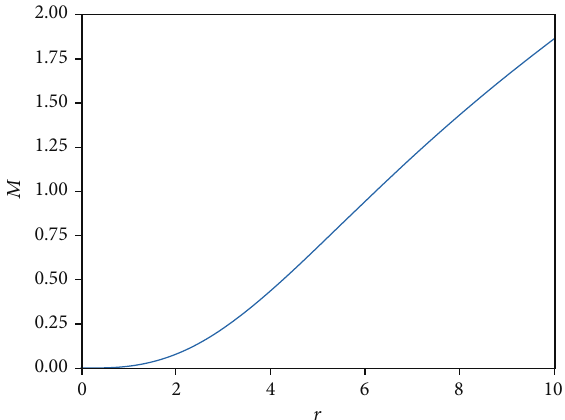
Figure 8: Variation of forces in TOV equation against radial distance r